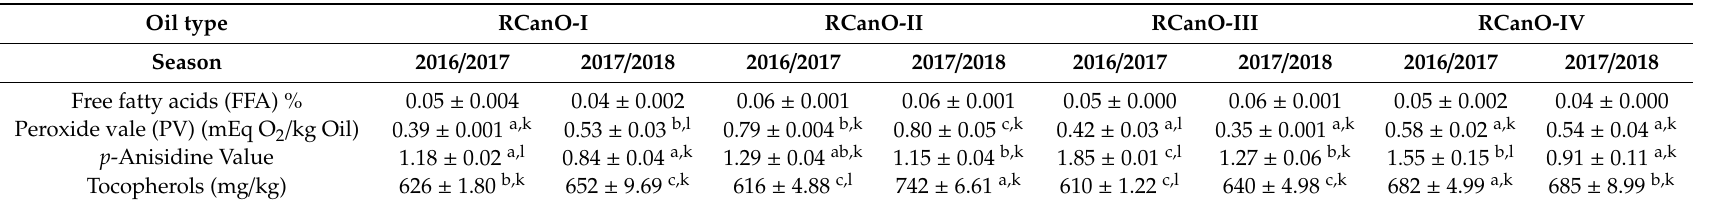
Table 1. Initial oil quality of canola oils from the 2016 / 2017 and 2017 / 2018 production seasons.